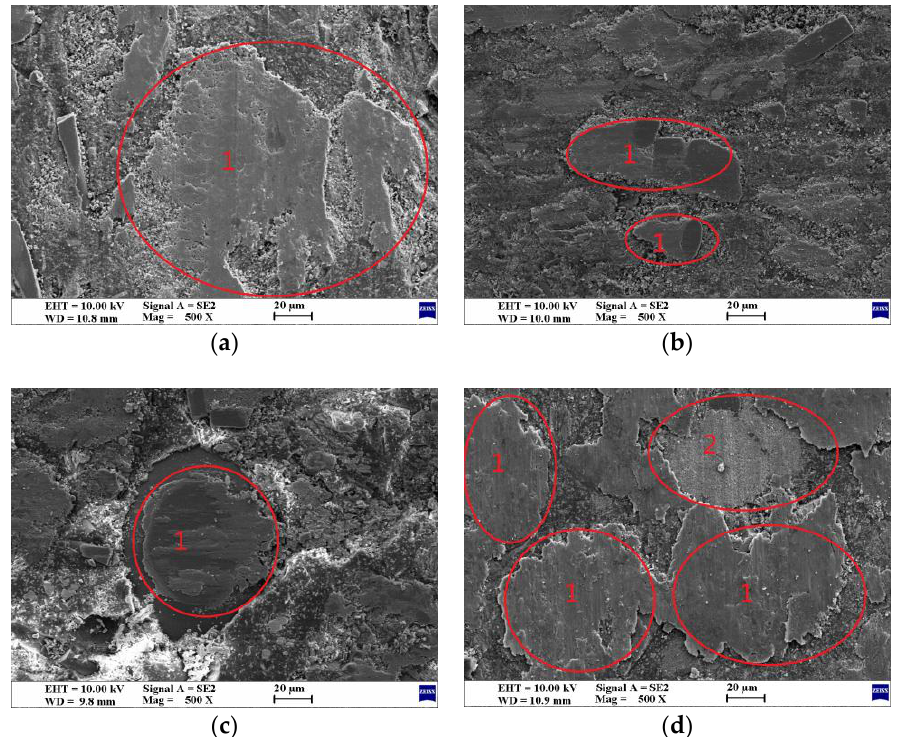
Figure 6. SEM micrographs of the worn surfaces of the brake composites: ( a ) C 10 L 5 ; ( b ) C 5 L 10 ; ( c ) C 15 L 0 ; ( d ) C 0 L 15 .